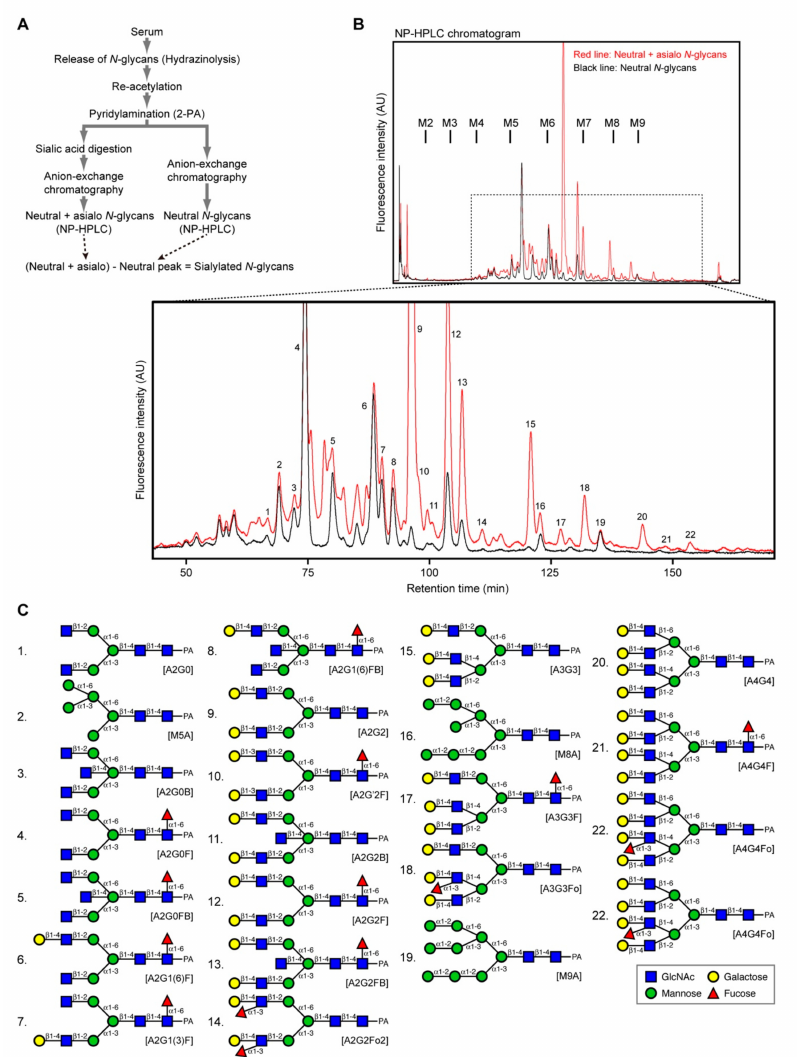
Figure 1. Scheme for human serum N -glycan preparation and profiling. ( A ) Serum N -glycan analysis strategy. ( B ) Chromatogram of normal-phase (NP)-HPLC shows the fluorescence-labeled neutral + asialo N -glycans (red line) and neutral N -glycans (black line). Elution positions of external standards (mannose-units: M2–M9) are shown. The lower panel shows the enlarged chromatogram between retention times 40 and 180 min. ( C ) The N -glycans of peaks 1–22 in Figure 1B were identified. All structures are shown as pyridylaminated (PA)